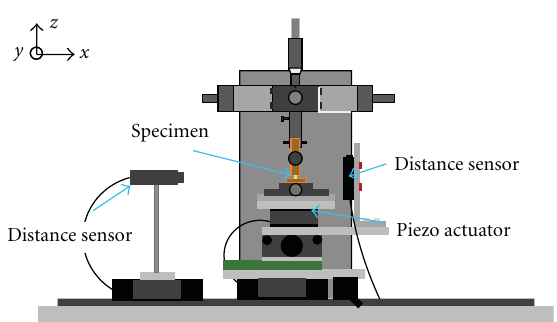
Figure 1: Apparatus for wear and fretting corrosion tests.